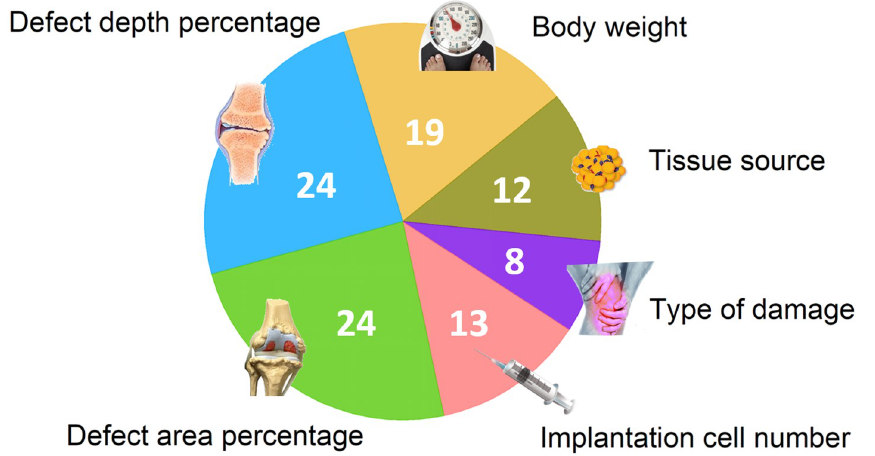
Fig 6. Illustration of the relative strength of properties used in our